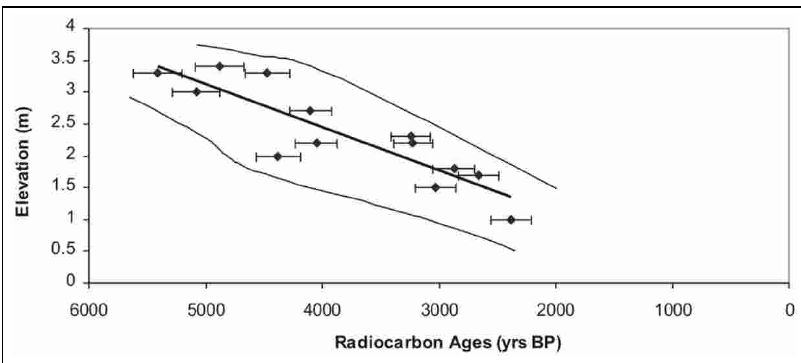
Fig. 2 – Radiocarbon dates obtained from Martin et al. (1996, 1997) for the coast between Serra (ES) and Guarapari (ES), south coast of Espirito Santo